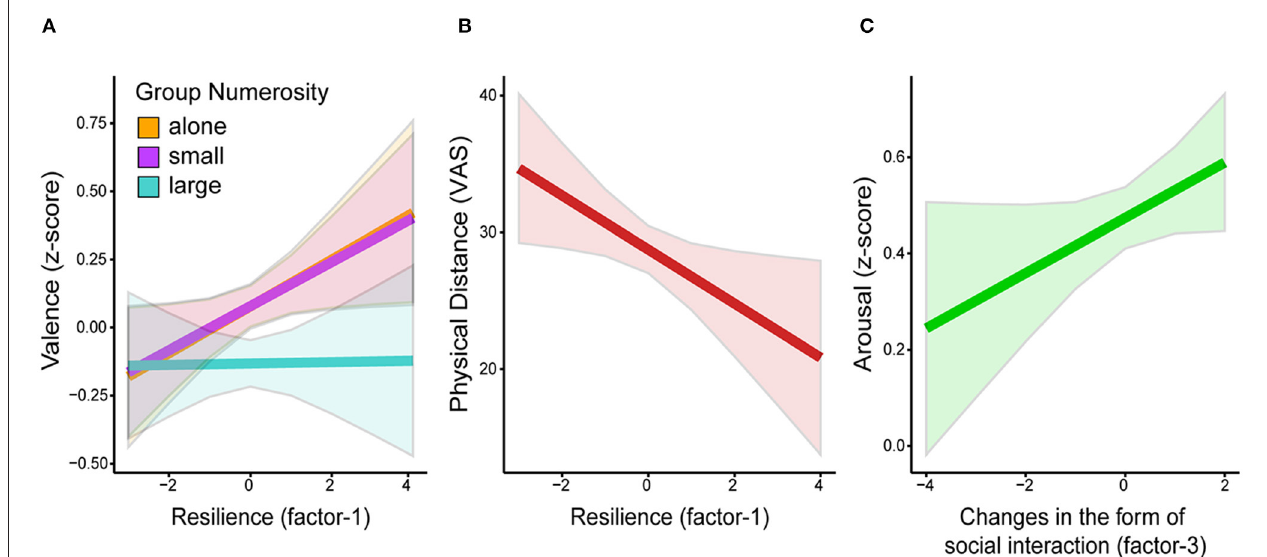
FIGURE 3 | Predicted values (marginal means and 95% CIs) of (A) z-scores of valence by Group Numerosity and factor-1 (“Resilience”); (B) ratings of physical distance by factor-1; and (C) z -scores of arousal by factor-3 (“Changes in the form of social interaction”).